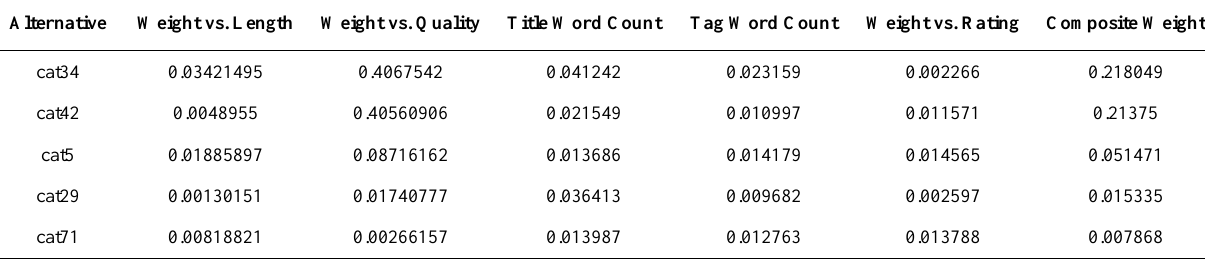
Table 3. Top Categories from the Utilized